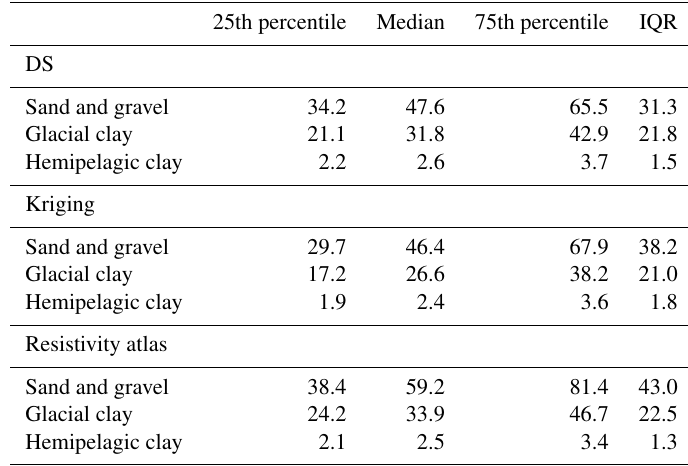
Table 1. The summary statistics table for the histograms in Fig. 4. The first section, named DS, shows summary statistics for the three histograms seen in Fig. 4a. The second section, named kriging, shows the summary statistics for the histograms in Fig. 4b. The last section, labeled resistivity atlas, shows the summary statistics for the resistivity atlas histograms in Fig. 4c and d. All the values presented in the table are resistivities ( (cid:127) ·